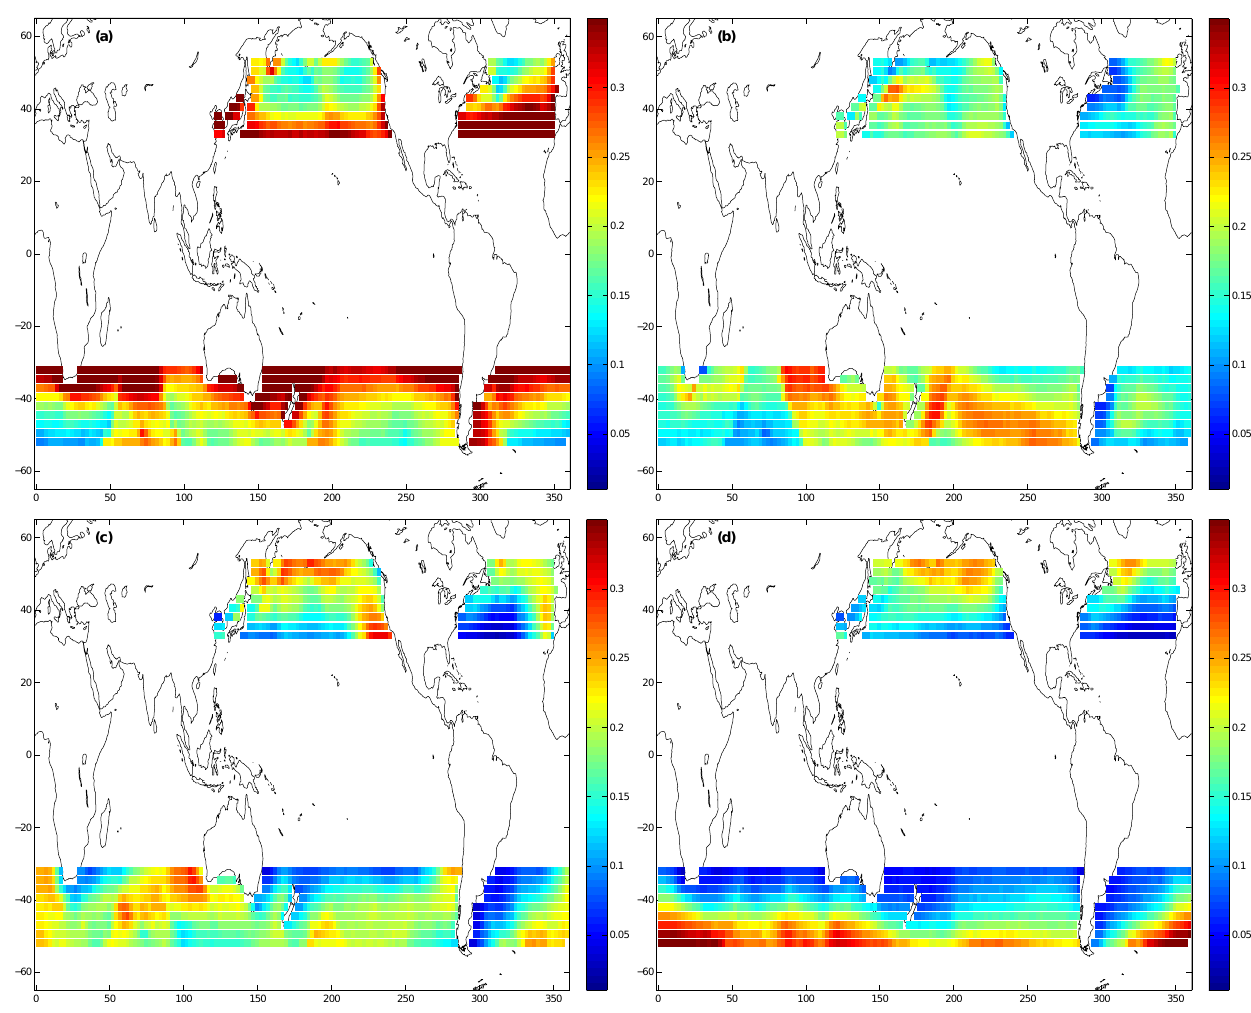
Fig. 8. Annual mean climatological spatial distributions of the frequency of each cluster, (a) Small Cumulus, (b) Large Cumulus, (c) Stratocumulus/Stratus, (d) Deep Altostratus, (e) Cirrus, (f) Weak Frontal, and (g) Strong Frontal.